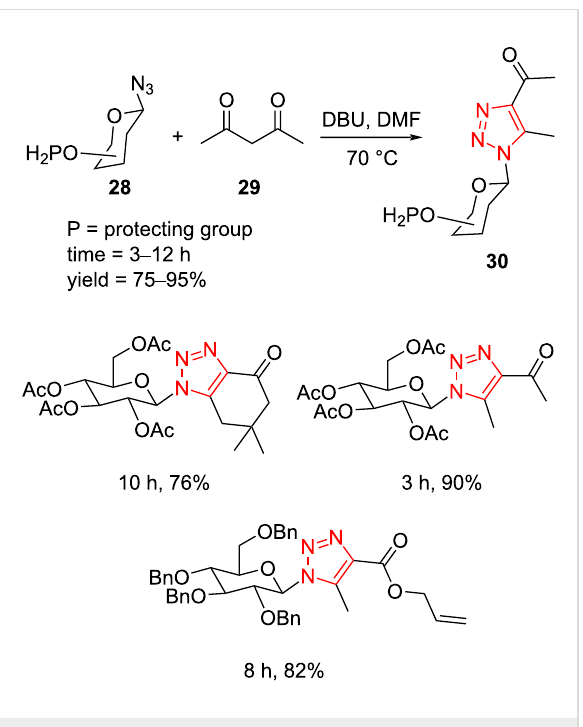
Scheme 12: Synthesis of 1,4,5-trisubstituted glycosyl-containing 1,2,3- triazole derivatives 30 from the reaction of glycosyl azides 28 with enolates of active ketones and esters 29